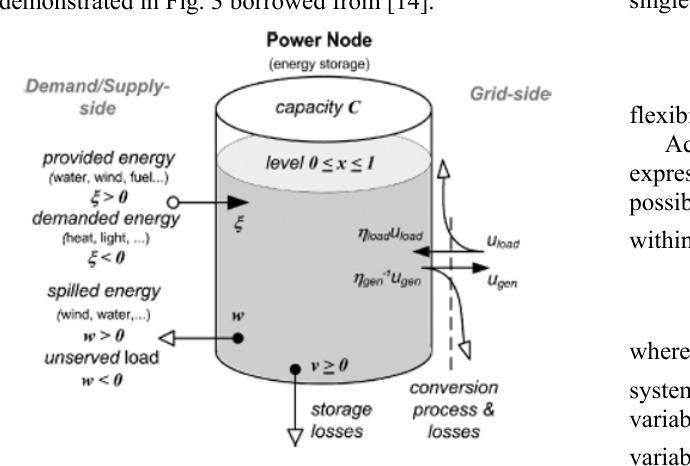
Fig. 3. Demonstration of exchange processes in the node with a storage